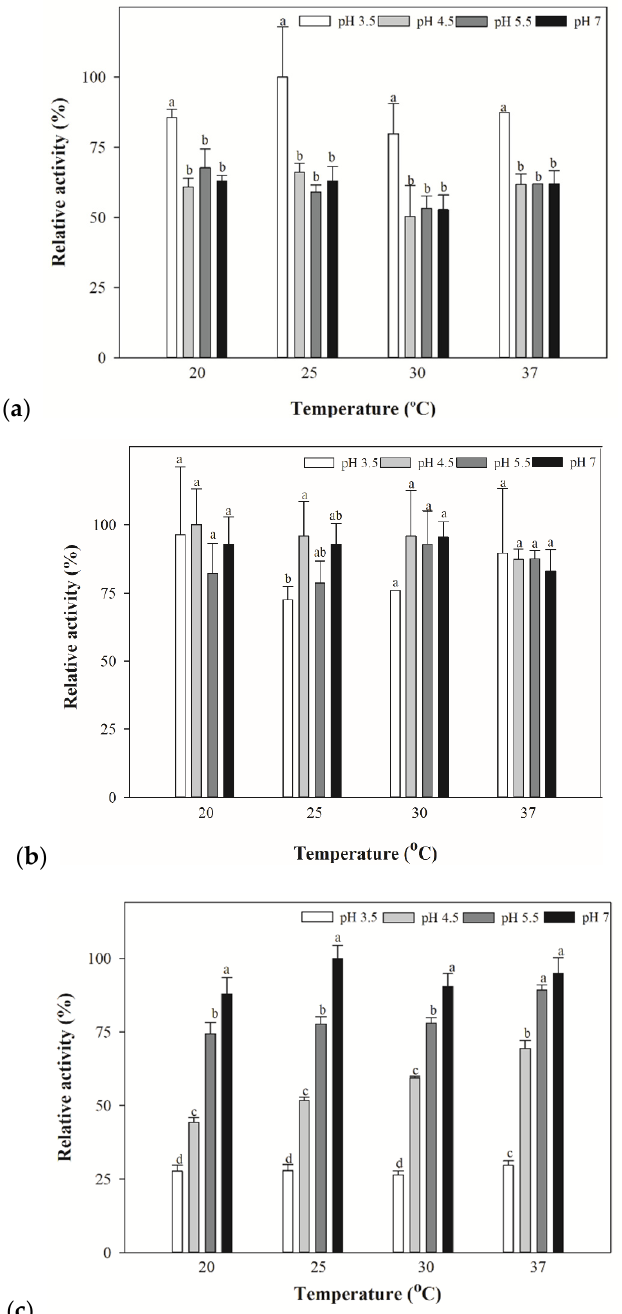
Figure 4. The β -lyase activity of ( a ) E. limosum , ( b ) Lb. casei, and ( c ) S. putrefaciens bacterial extracts at various temperatures and pH. The C-S β -lyase specific activities were determined by the DTNB assay using 1 mM L -cystathionine at 20, 25 30, and 37 °C, and at pH values of 3.5, 4.5, 5.5, and 7.0. Relative activity of 100% represented the highest value among all the specific activity in different temperatures and pH. Data are expressed as mean ± standard deviation ( n = 3). Different lower case letters in the same grouped bars indicate significant differences ( p < 0.05).